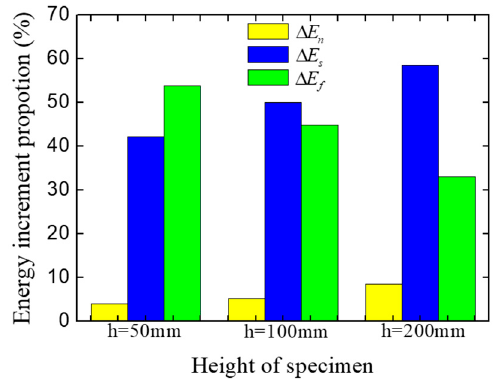
Figure 25. Energy increments proportion of the concrete specimen with different specimen heights at the pre-peak stage.